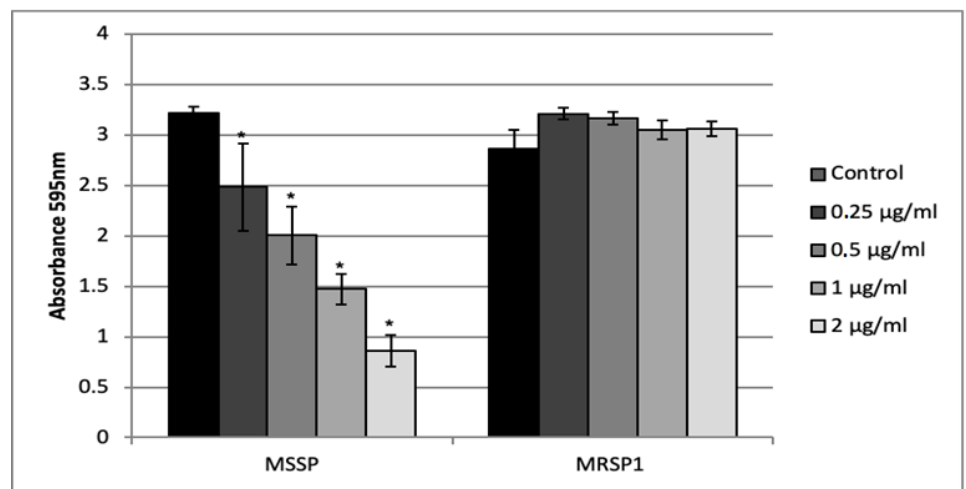
Figure 3. Activity of the abietic acid on S. pseudintermedius biofilm formation. Values represent the mean ± SD for three independent experiments. * indicates statistically significant difference ( p < 0.05).